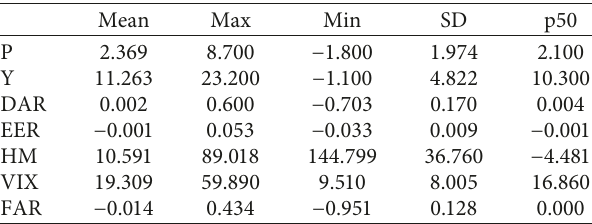
Table 1: Descriptive